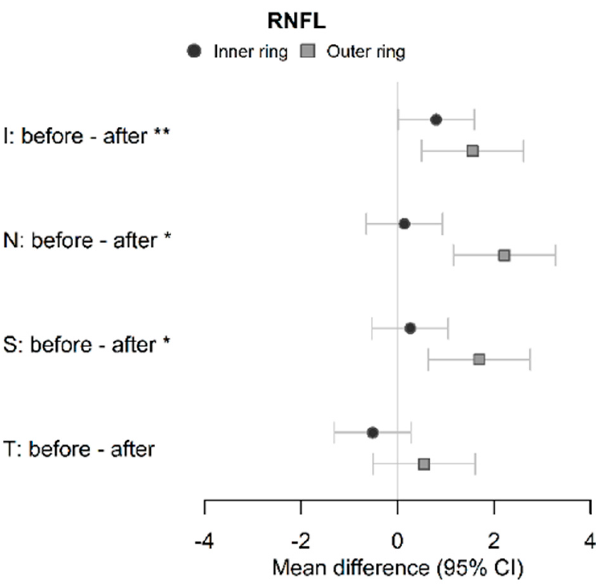
Figure 2. Forest plot of mean differences in RNFL thickness between the COVID-19 patients in the acute phase (before) and at 1-year follow-up (after) with 95% CI. ** p < 0.05 in the inner and outer ring; * p < 0.05 in the outer ring; RNFL, retinal nerve fiber layer; CI, confidence interval.